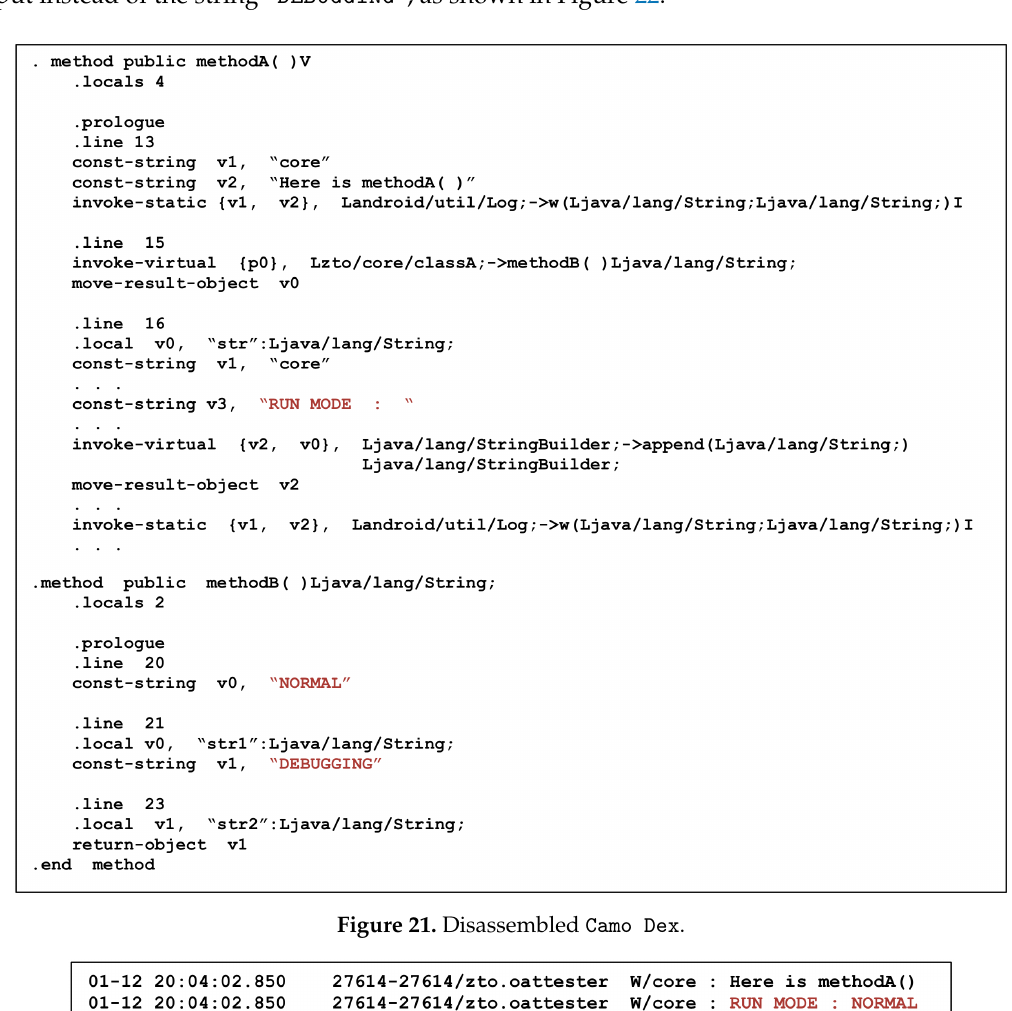
Figure 22. Result of Method A